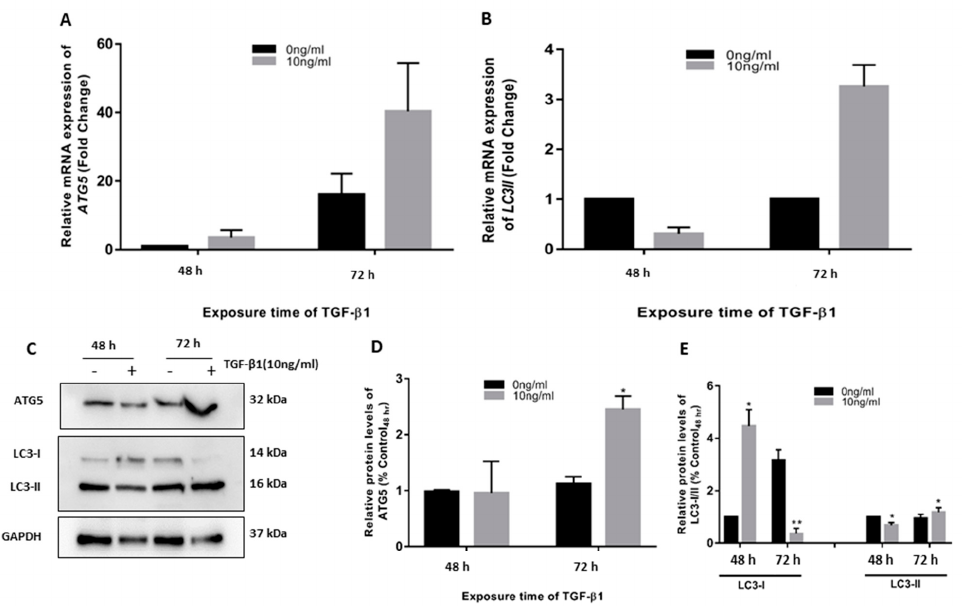
Figure 1. TGF- β 1 induced ATG5 activation in human trabecular meshwork (HTM cells). TGF- β 1 (10 ng/mL) applied to primary HTM cells for 48–72 h, increased relative mRNA expression of ( A ) ATG-5 and ( B ) LC3-II. It also increased levels of ( C ) ATG-5 proteins and lipidation of LC3 II, ( D , E ) Densitometry analysis of bands. The results represent the averages of three separate tests conducted. The error bars represent the standard deviation (*— p < 0.05, **— p < 0.01, by t -test).